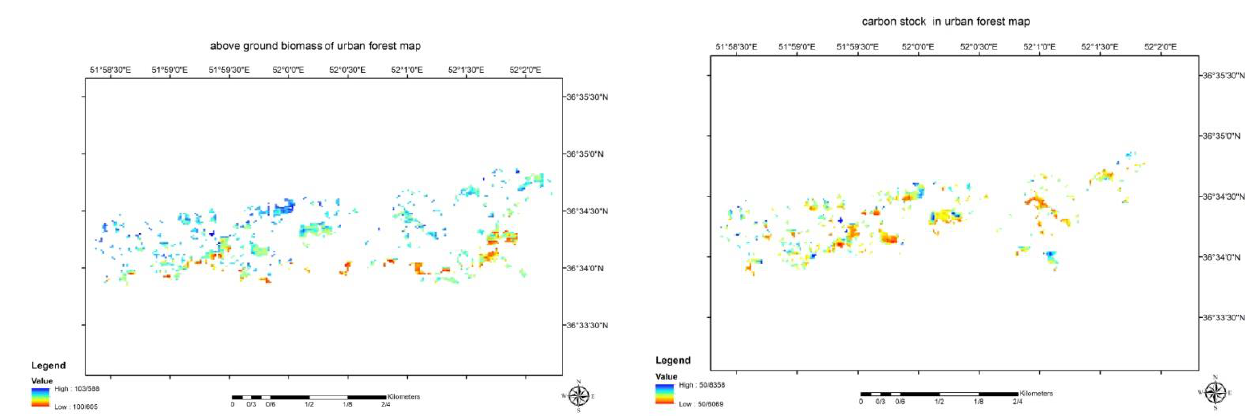
Table 2. The best selection indexes of the data for biomass estimation in GA-SVM.